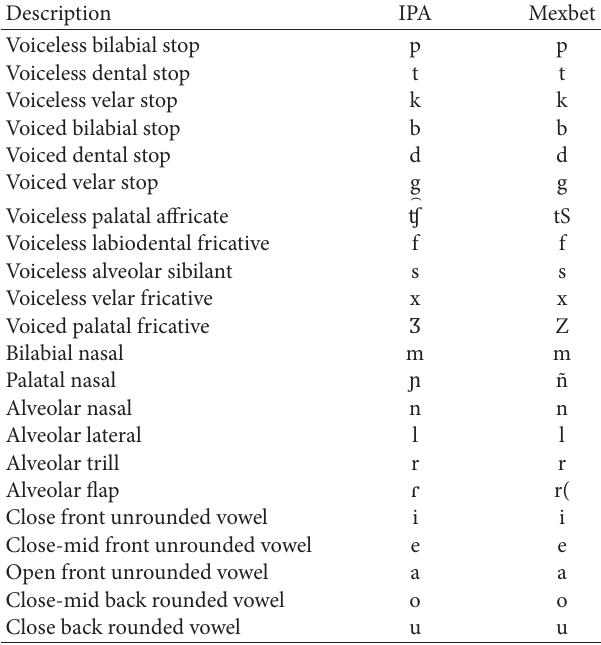
represent the pronunciation of the sequence of phonemes /k/ and /s/ (as in “extra”), and the silence, the phonemes /ks/ and /sil/ were added. This led to a final alphabet of 28 phonemes for this